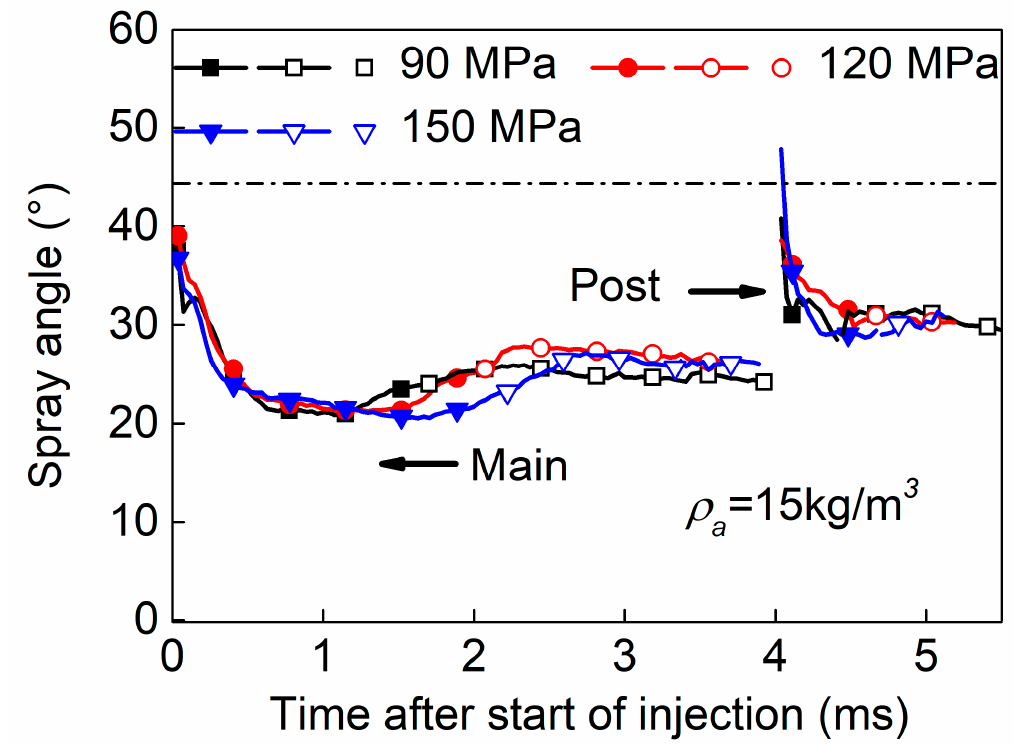
Figure 12. Results of spray angle evolvements when applying the main-post injection strategy under various injection pressures.